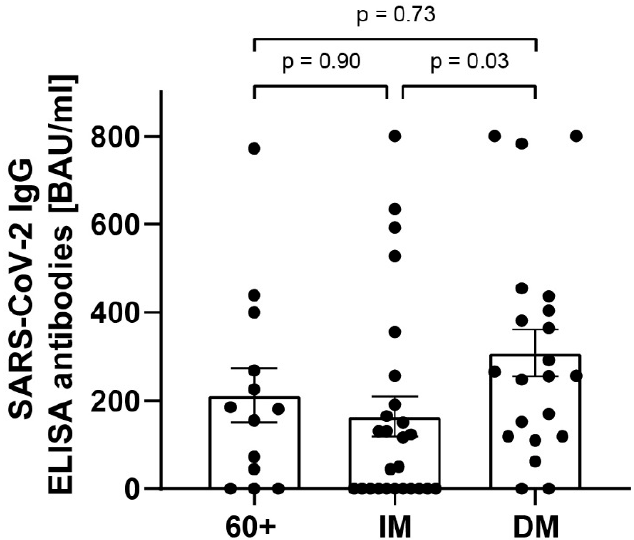
Figure 4. SARS-CoV-2 IgG ELISA levels of elderly (60+), immunocompromised (IM) and diabetes mellitus (DM) patients. SARS-CoV-2 IgG ELISA levels of 60 patients were determined via antibody assay. Each dot ( • ) represents one patient. Comparison between the groups was performed with the Kruskal–Wallis test. Statistical significance was set at the level of p < 0.05.